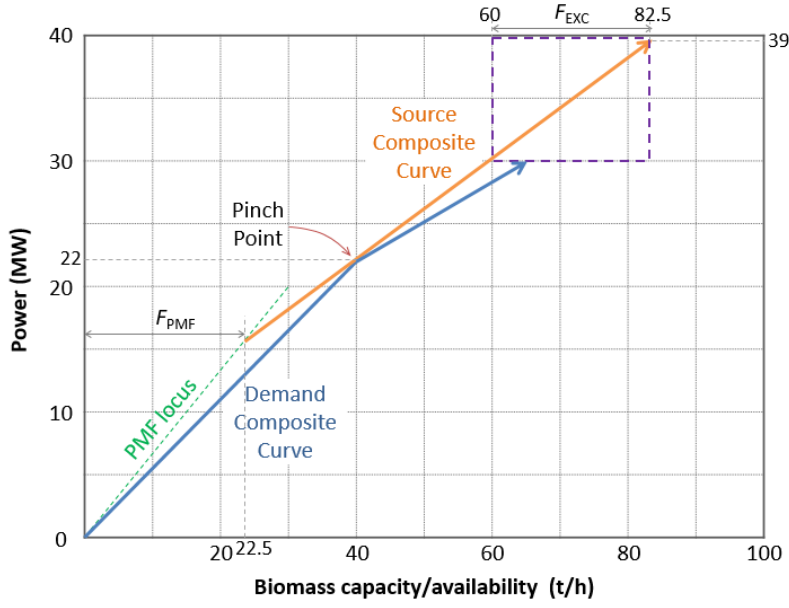
Figure 5. BEPD with minimum PMF.